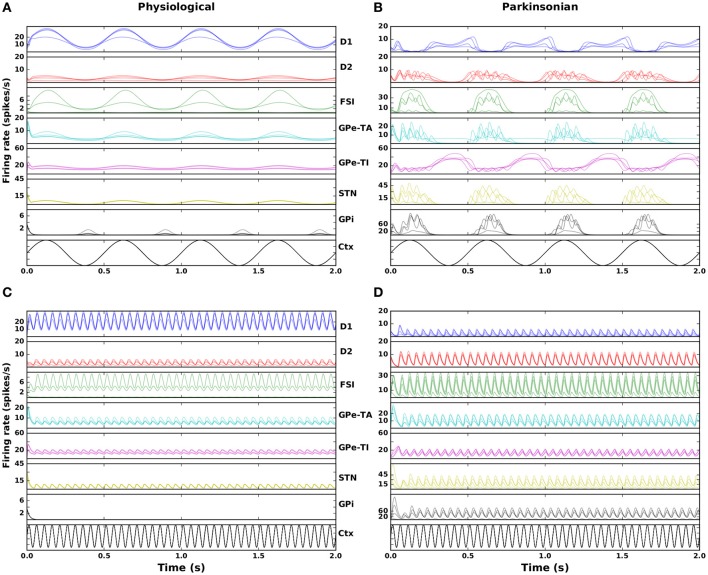
Nucleus specific response to cortical stimulation. Left column: physiological condition, right column: parkinsonian condition. (A,B) Activity in the seven modeled nuclei in response to cortical slow wave activity (black curve) for four randomly selected networks. (C,D) As in (A,B) but for cortical beta activity.